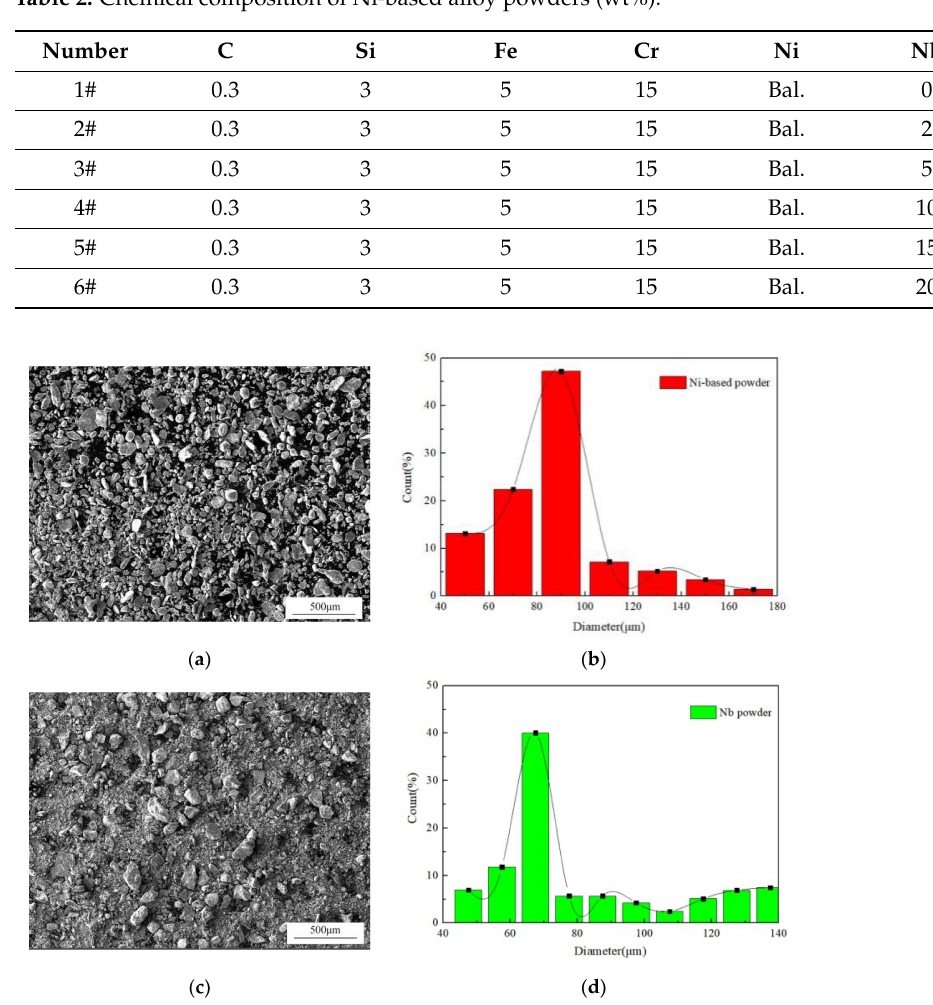
Figure 2. Powders morphology: ( a ) Ni-based alloy powder; ( b ) particle size distribution of Ni-based powder; ( c ) Nb powder; and ( d ) particle size distribution of Nb